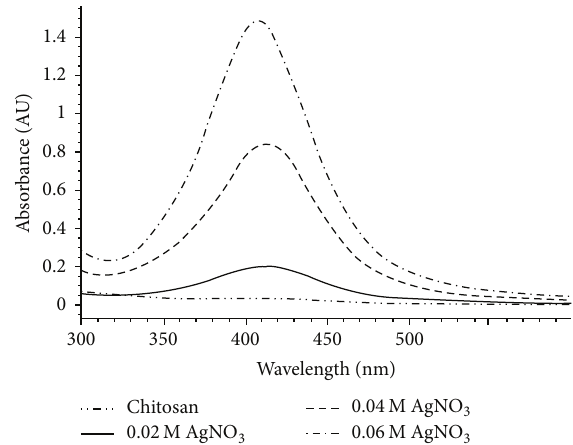
Figure 1: UV-vis absorption spectra of chitosan-Ag nanoparticle materials synthesized with 0.02 M, 0.04 M, and 0.06 M AgNO 3 and pure chitosan.